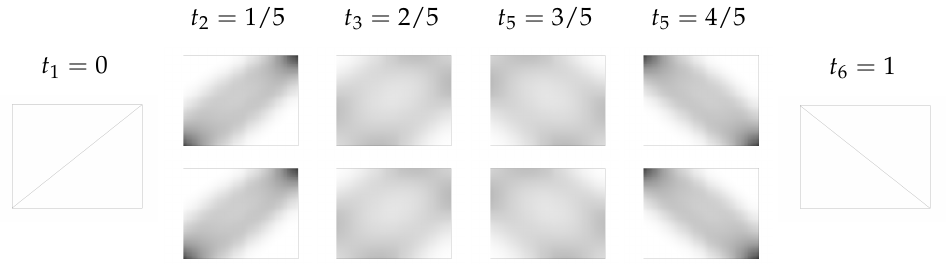
Figure 8. Joint measures Π 1, k , k = 2, · · · ,5 representing the movement of the particles from initial position x ∈ [ 0,1 ] ( x -axis) to position x t Sinkhorn algorithm. Second row: NFFT-Sinkhorn algorithm.